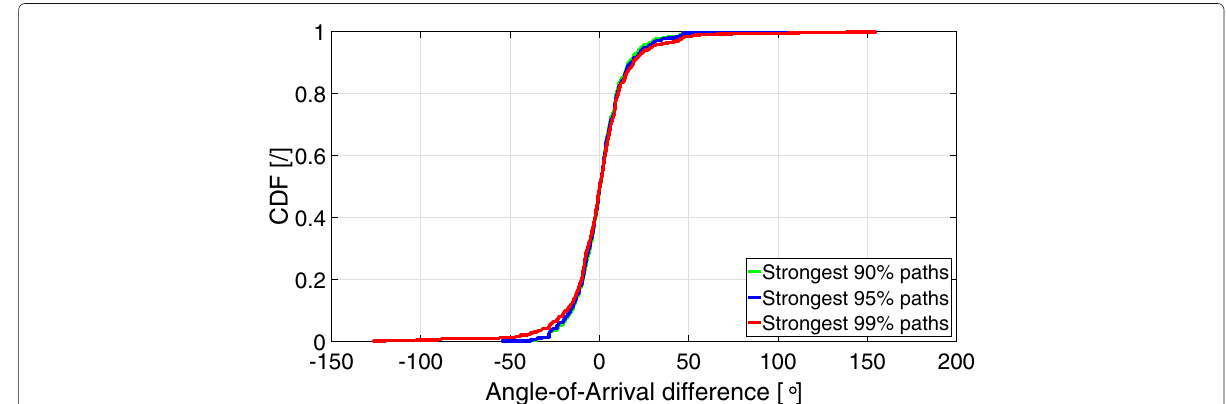
Fig. 6 CDF of AoA differences between the input and output strongest 90, 95, and 99% propagation paths